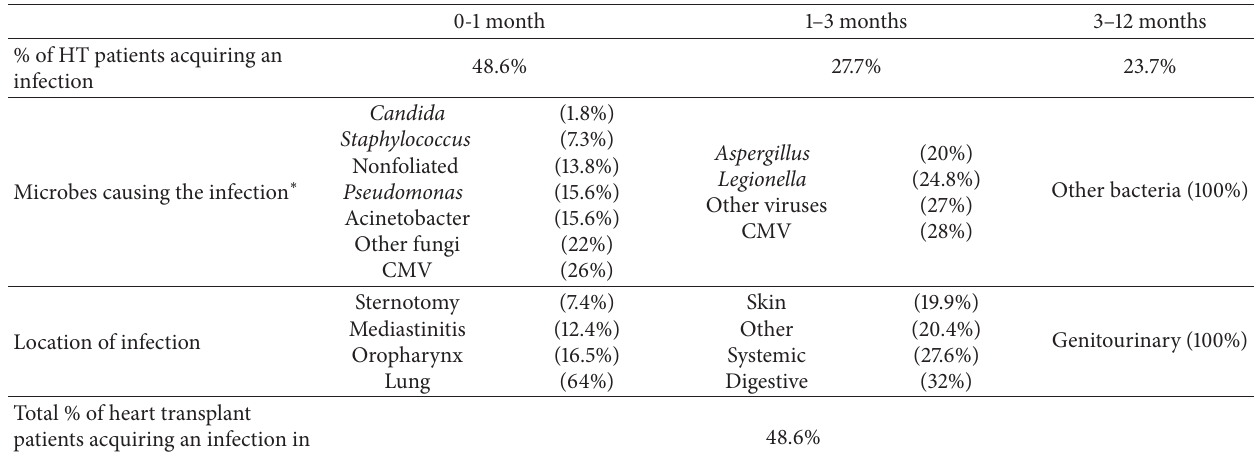
Table 1: Chronology of infections after heart transplantation